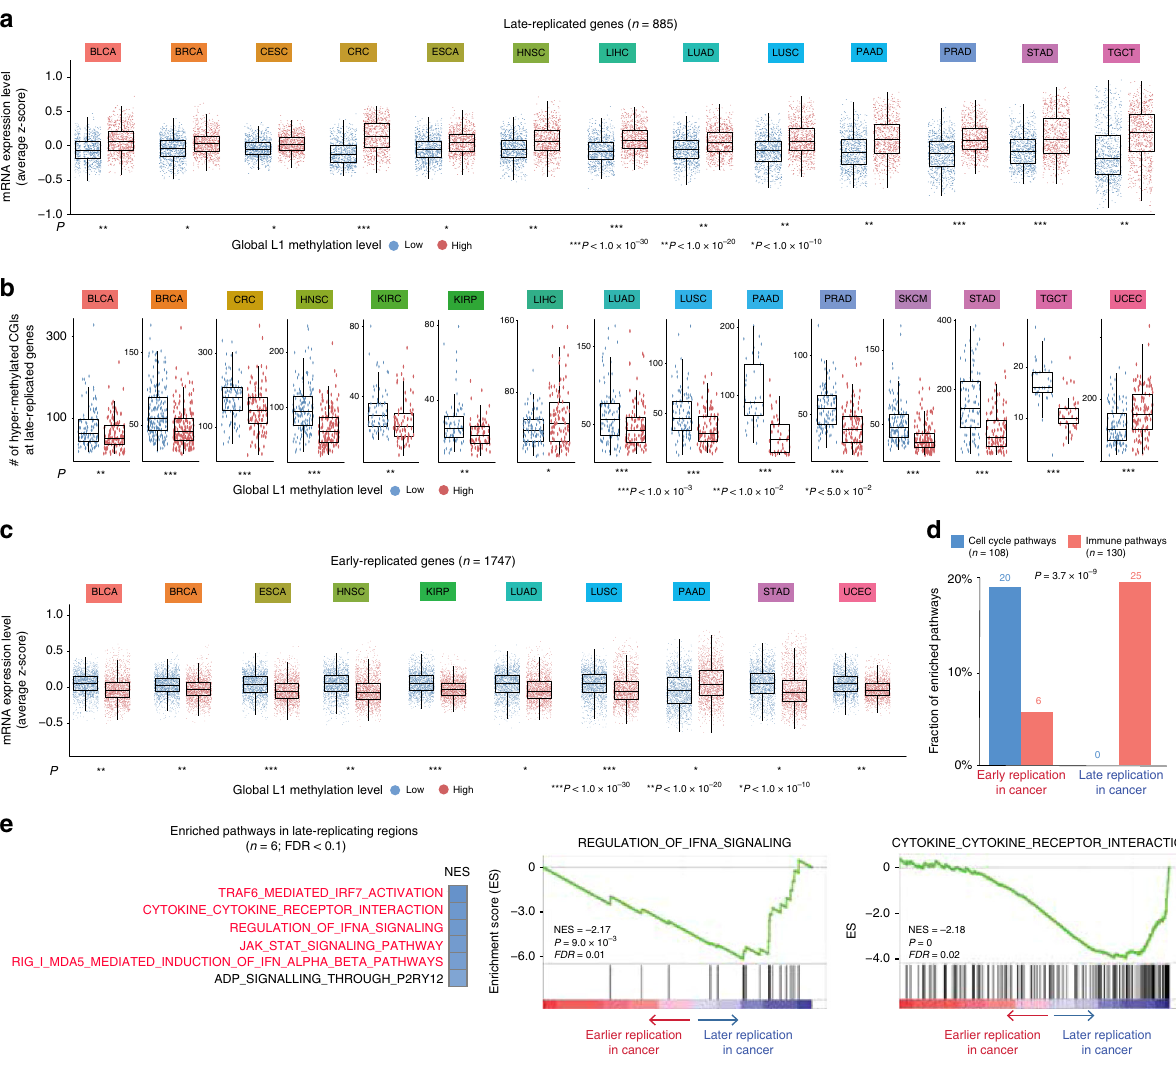
Fig. 3 Characterization of genes in late-replicating regions. a Comparison of the expression levels of late-replicated genes between tumours with low and high global methylation. Tumour types for which the paired t -test P < 1 × 10 − 10 are shown. b Comparison of the number of hypermethylated CpG island promoters of late-replicating genes between tumours with low and high global methylation. Tumour types with P < 0.05 (two-sided Mann – Whitney U test) are shown. In the boxplots, the centre line, bounds of box, and whiskers represent the 50 th , 25 th and 75 th , and 5 th , and 95 th percentiles, respectively. c Comparison of the expression levels of early-replicated genes between tumours with low and high global methylation. Tumour types for which the paired t-test P < 1 × 10 − 10 are shown. d Fraction of enriched cell-cycle and immune pathways according to replication timing. The number of the pathways showing signi fi cant enrichment (FDR <0.25) by GSEA is indicated above the bars. e Signi fi cantly enriched pathways for genes in late-replicating regions and the two representative GSEA plots. Genes that are speci fi cally expressed in the immune system were